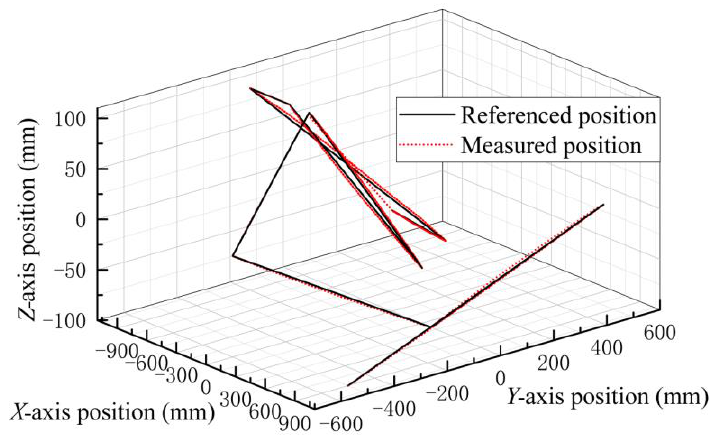
Figure 17. Random-curve dynamic tracking of a three-axis translation table.